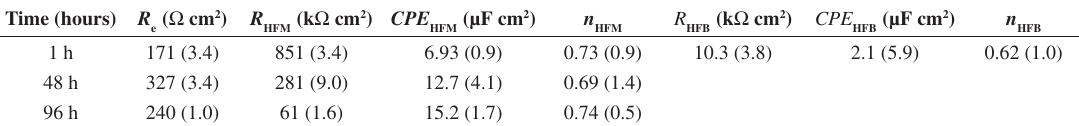
Table 8. Electrical elements fitted values for F1P90D film up to 96 h of immersion in 0.05 M NaCl solution. The error % associated with each parameter value is given in